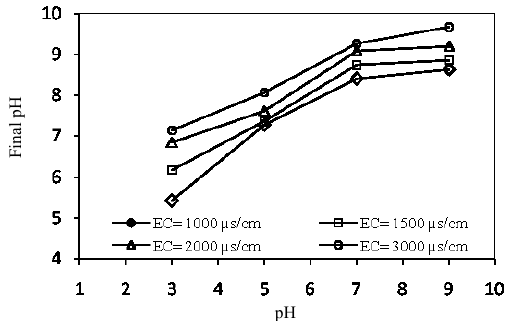
Figure 4. Variation of initial pH during electrocoagulation process (initial concentration of HA: 20 mg L -1 , applied voltage: 50 V and reaction time: 75 min).